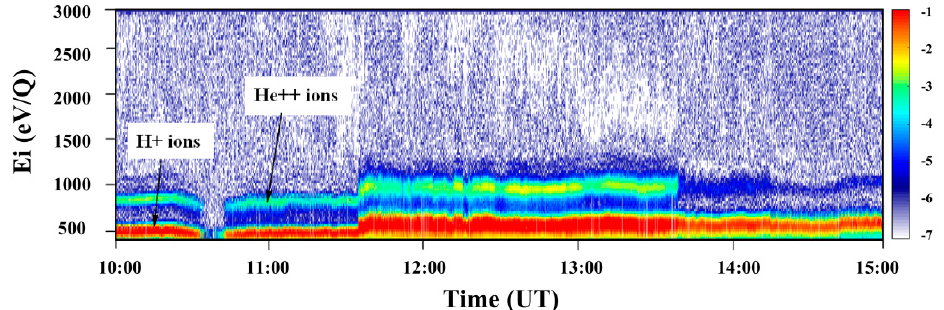
Figure 3. Energy–time spectrogram of the ion flux measured on 30 September 2012 by the BMSW instrument.